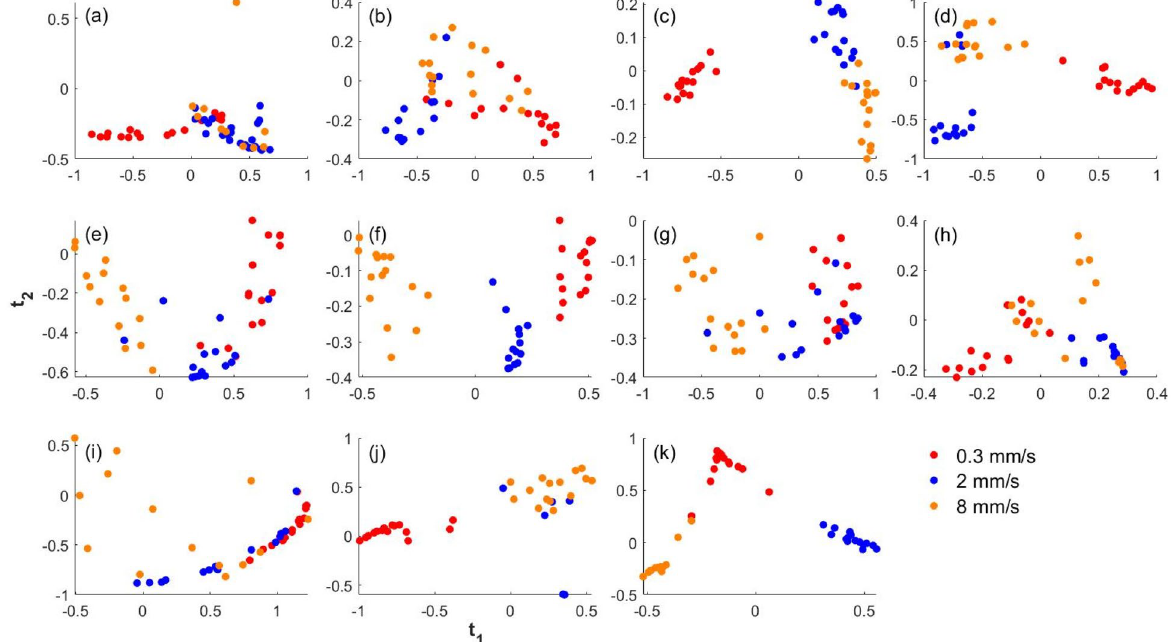
Figure 3. The kFDA scores of the samples of the ( a ) burned porcine skin tissue and the ( b )–( k ) 10 synthetic tissues loaded at the three rates along the two projections (t 1 and t 2 ) calculated from the kFDA based classification